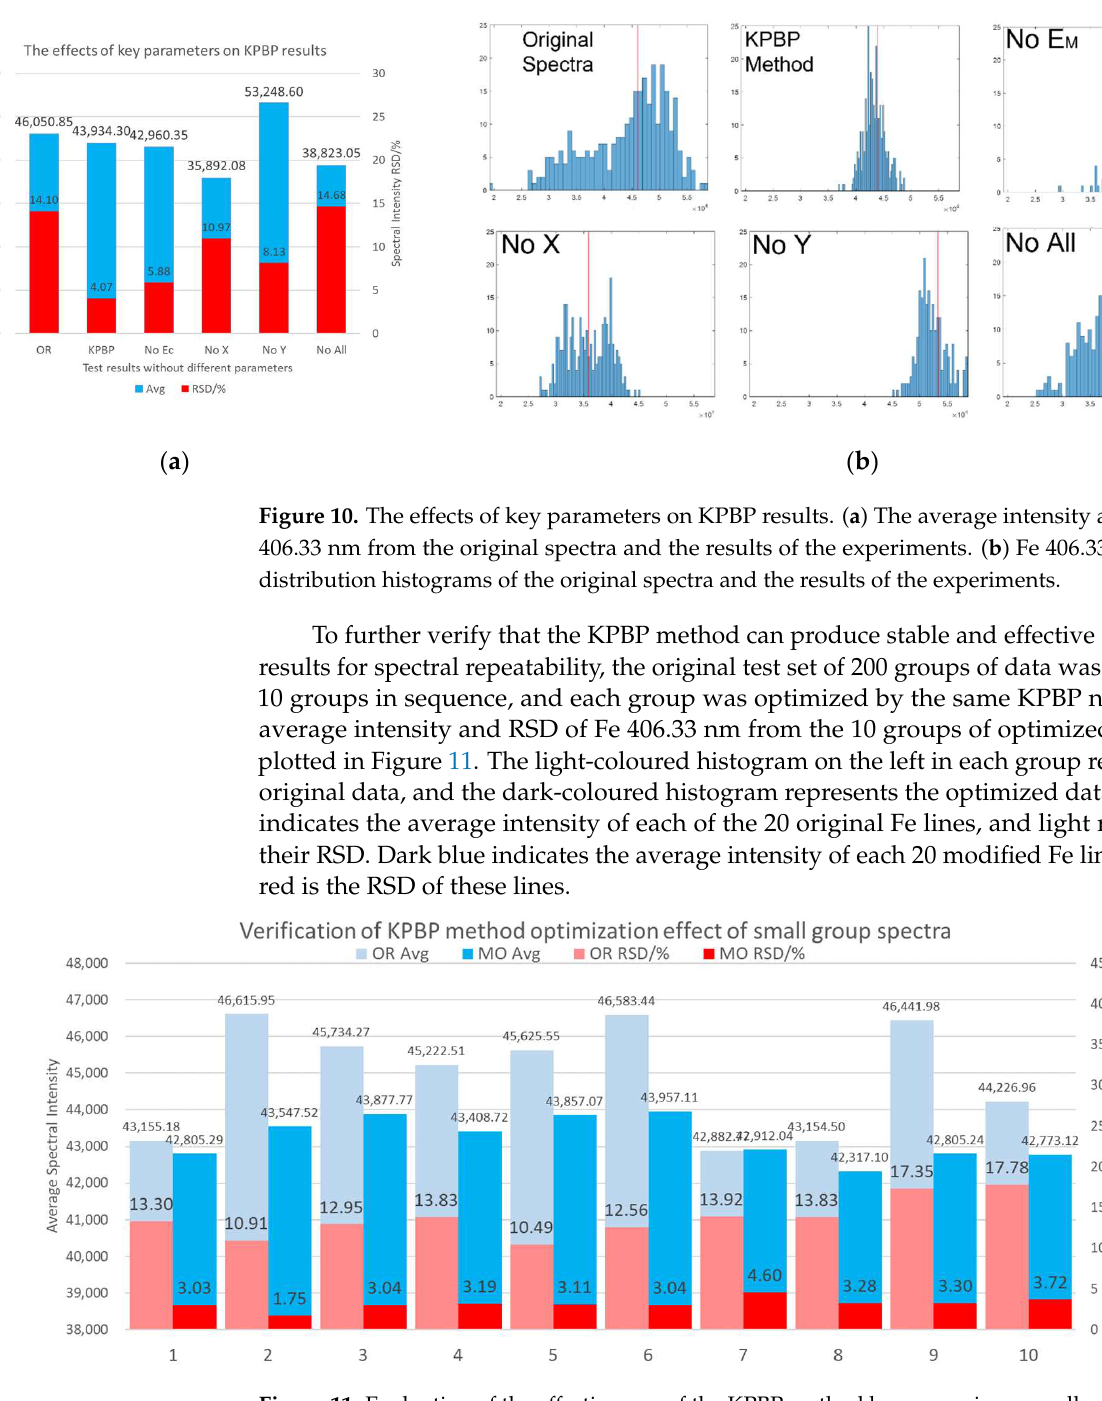
Figure 11. Evaluation of the effectiveness of the KPBP method by comparing a small spectral group’s standardization results.